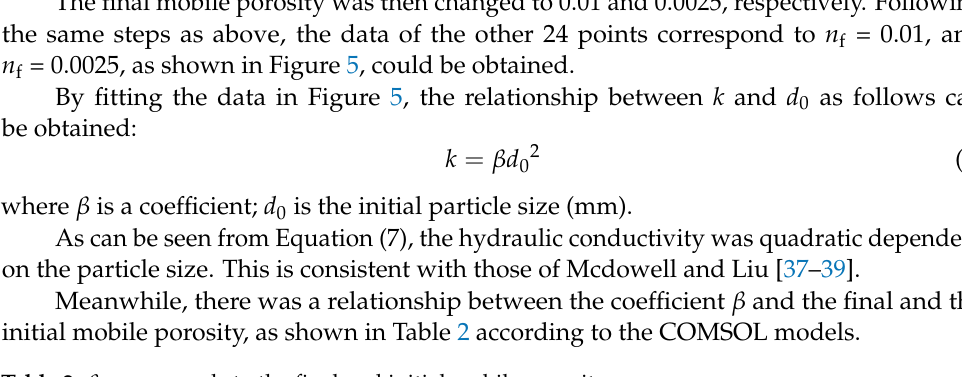
Table 2. β corresponds to the final and initial mobile